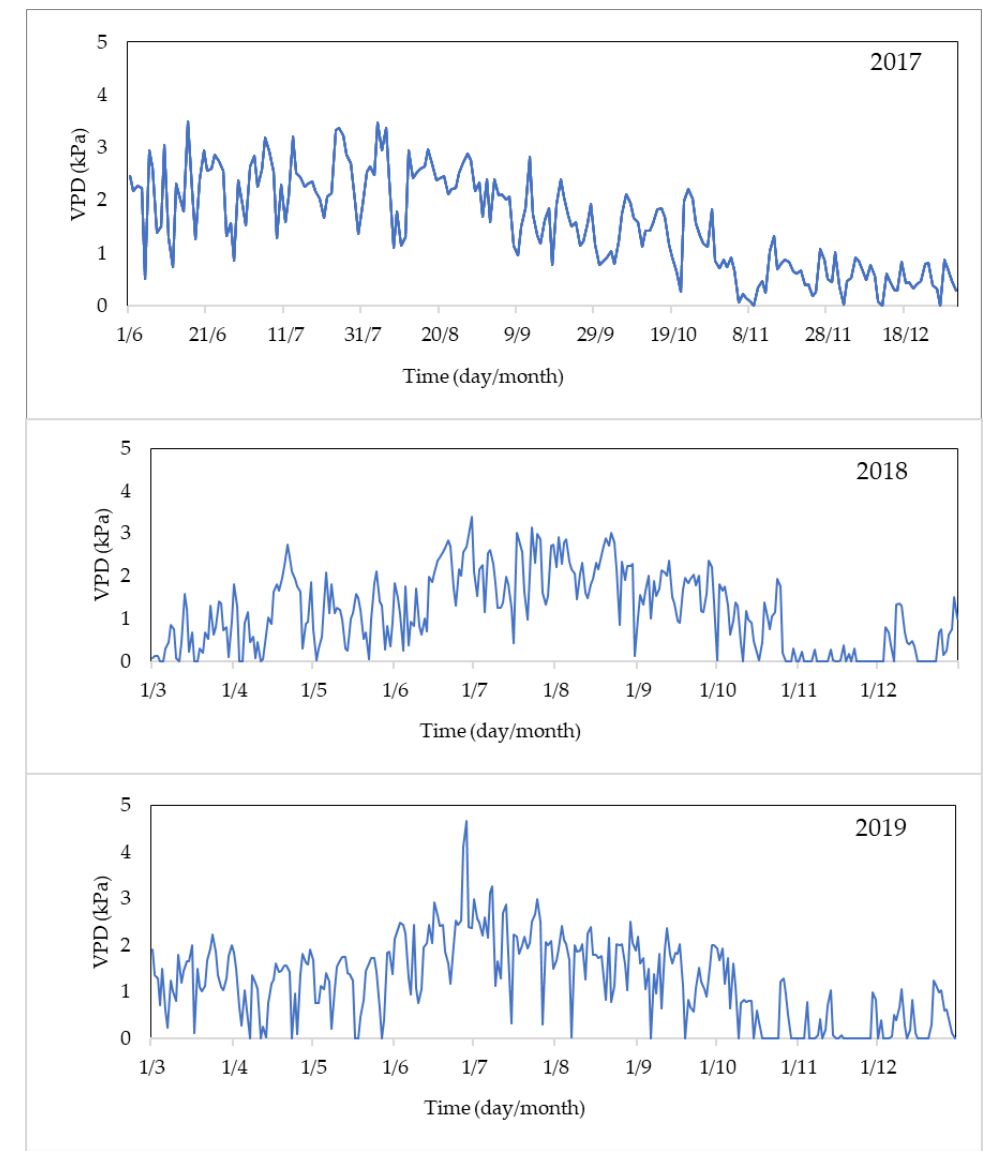
Figure 9. Vapor pressure deficit VPD (kPa) daily maximum values recorded throughout the three years (2017 – 2019) by a METOS ® station (Pessl Instruments GmbH, Weiz, Austria) located into the experimental orchard.